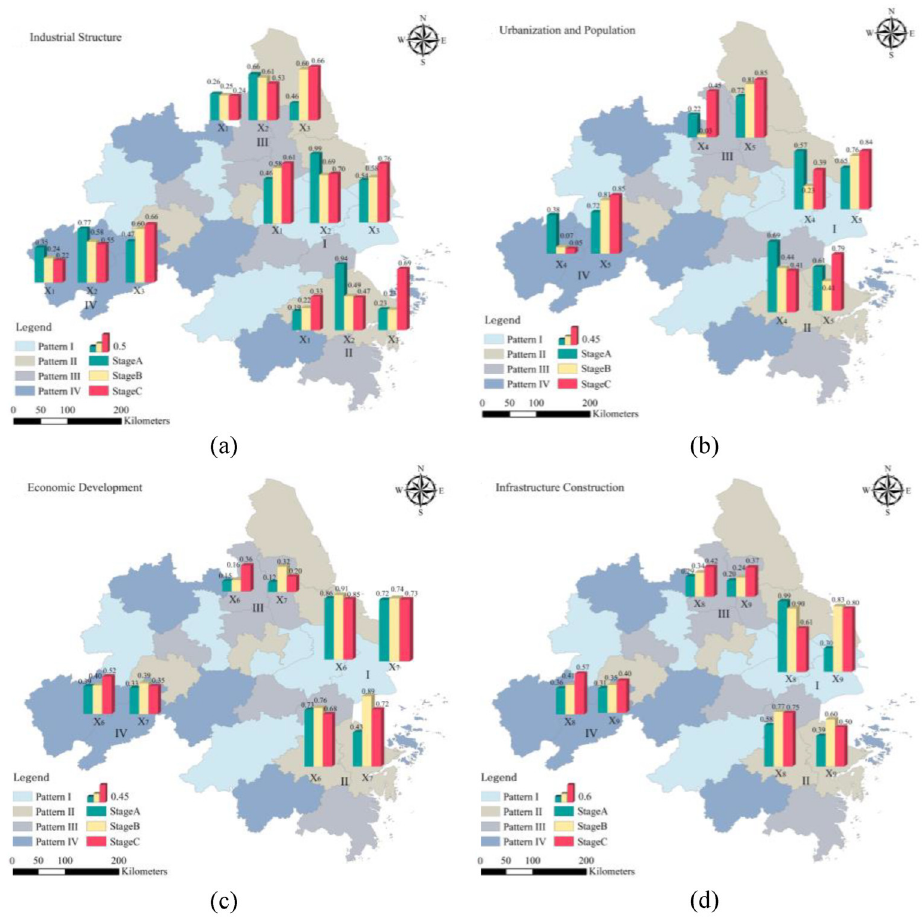
Figure 9. Results of the GDM for each factor in the four types of